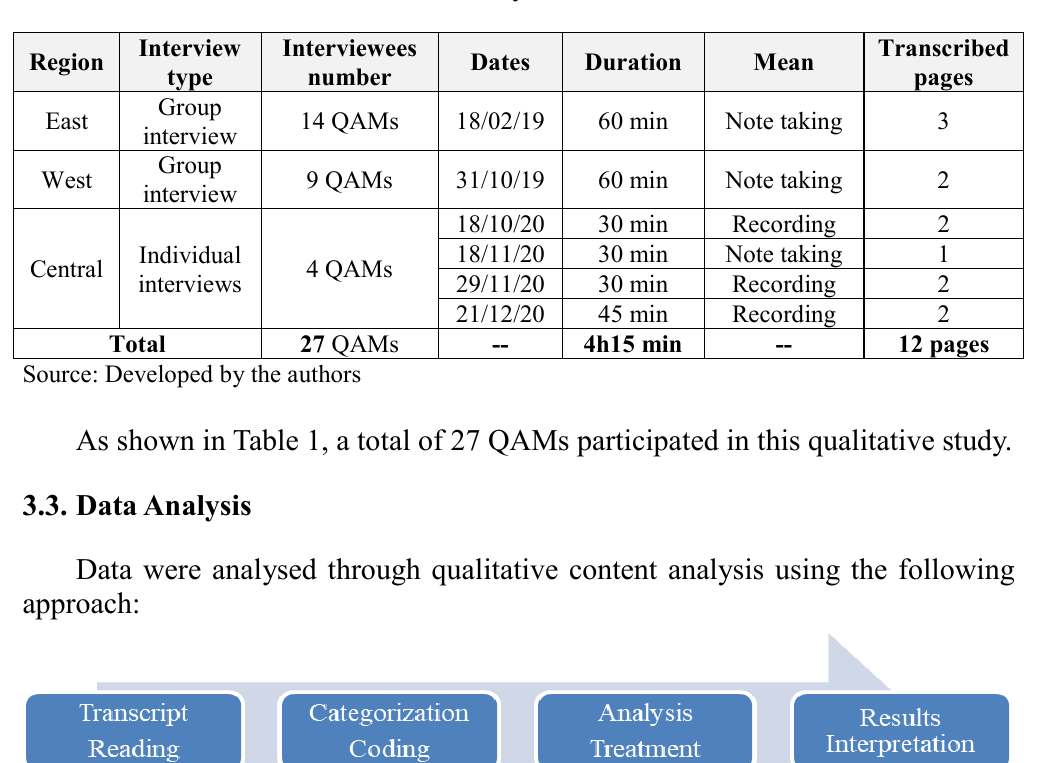
Table 1. Summary of the